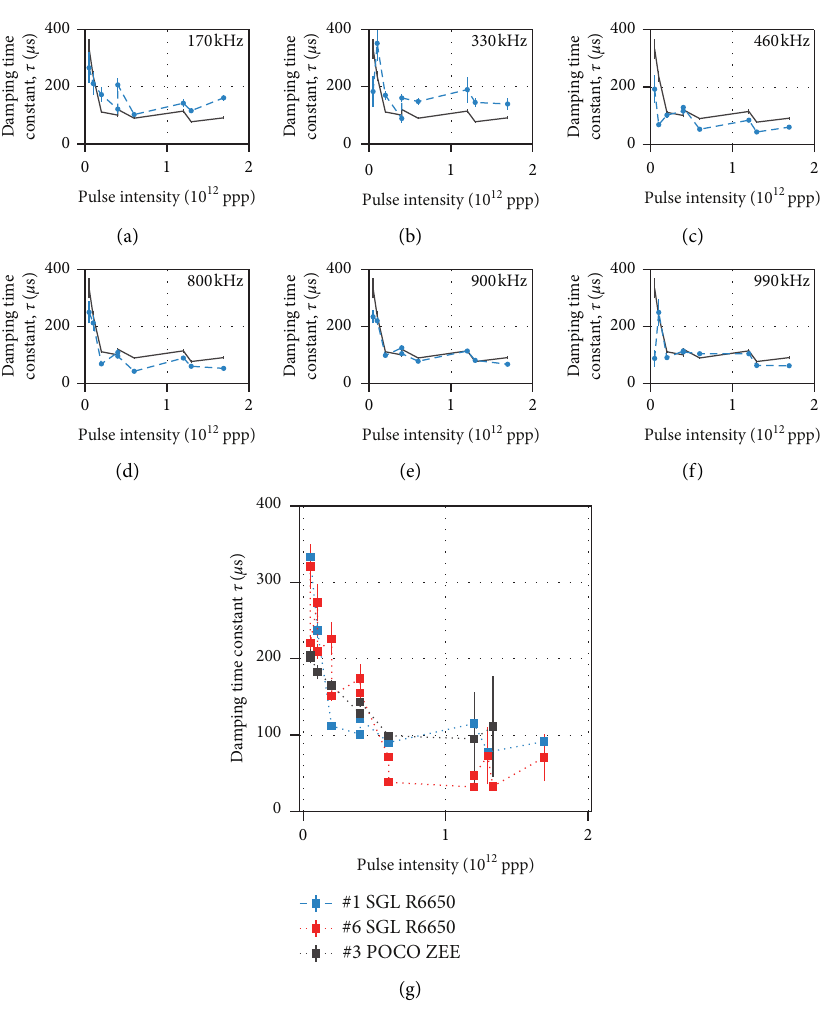
Figure 11: Evolution of the damping time constant, τ . Damping time constant as a function of beam intensity for different frequency components (blue markers) of sample #1 SGL R6650 obtained from continuous wavelet analysis in comparison to the damping time constant (black line) of the radial surface velocity (a–f). Damping time constant of the radial surface velocity for samples #1 SGL R6650, #6 SGL R6650, and #3 POCO ZEE as a function of pulse intensity (b).